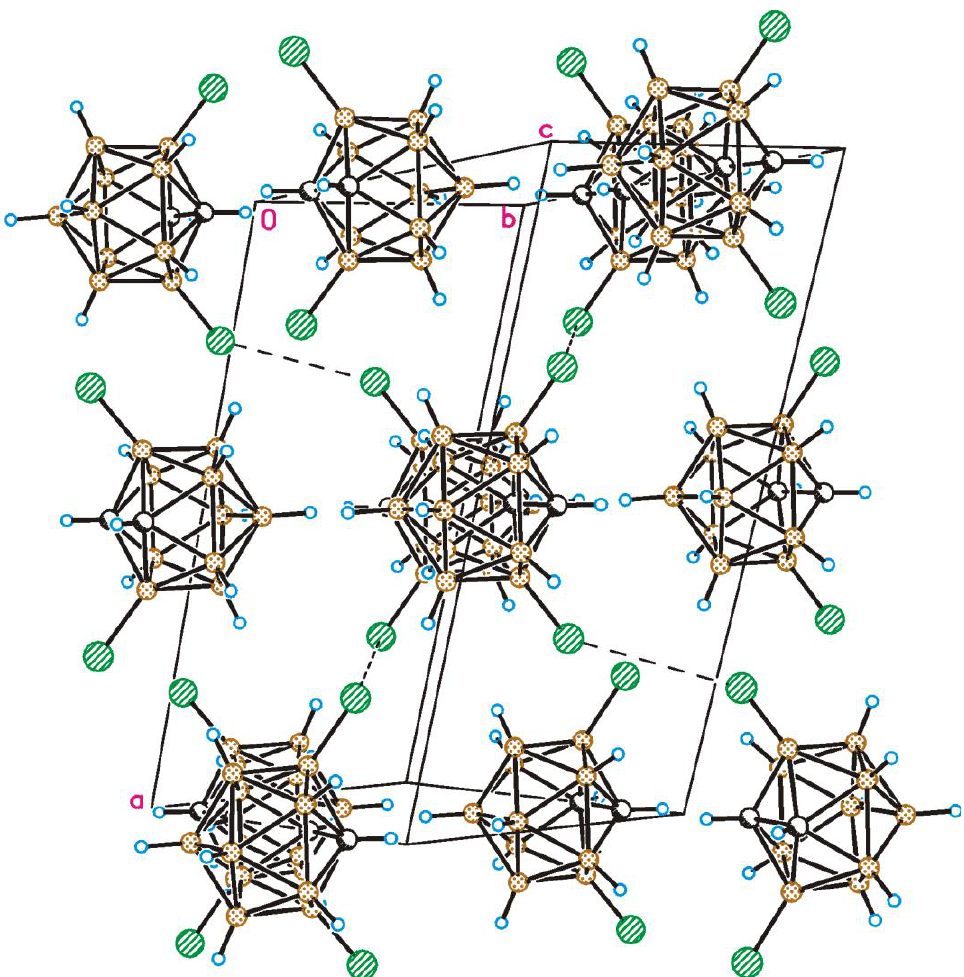
Figure 2. Crystal packing fragment of 3,6-Cl 2 -1,2-C 2 B 10 H 10 . The Cl…Cl contacts are shown by dashed